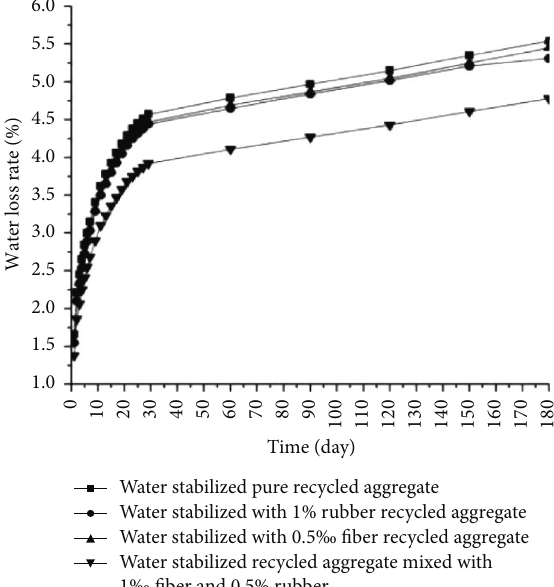
Figure 18: Comparison diagram of moisture loss rate in dry shrinkage test.